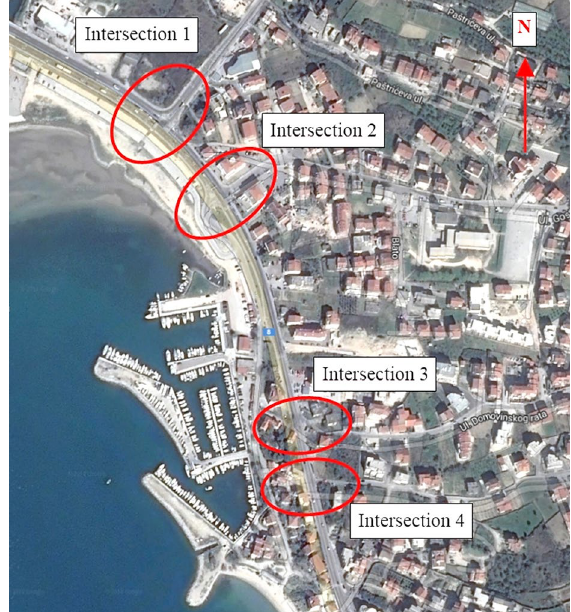
Fig. 2. Image of the stretch of national road D8 under